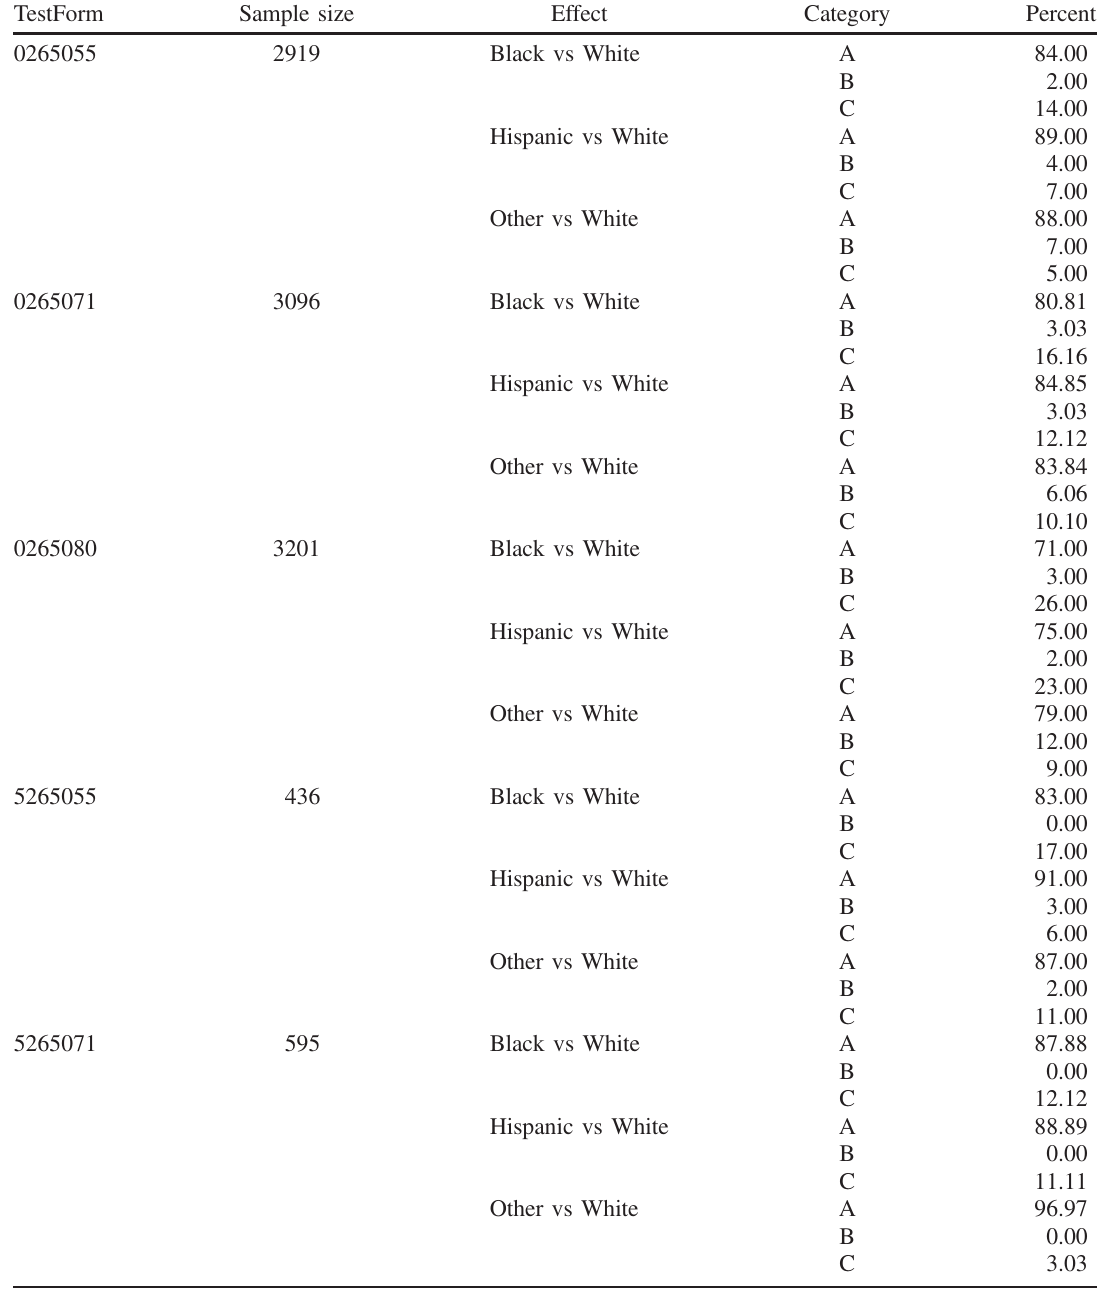
TABLE VI. Race or ethnicity differential item functioning analysis of Praxis physics subject assessments test forms from 2006 to 2016. Item categories (ABC) were determined using form-specific scores for White (reference group) and each listed ethnicity (focal group). Data is listed as “ focal group vs reference group. ” DIF analysis for test forms 5265134 and 5265142 are not included due to an insufficient number of test takers of each race or ethnicity for these most recently administered